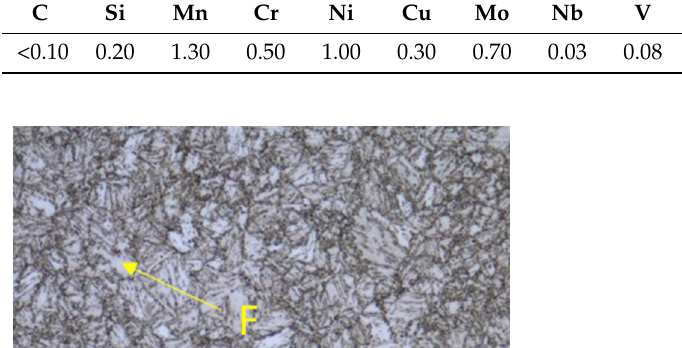
Table 1. Chemical composition of the experimental steel (wt%).